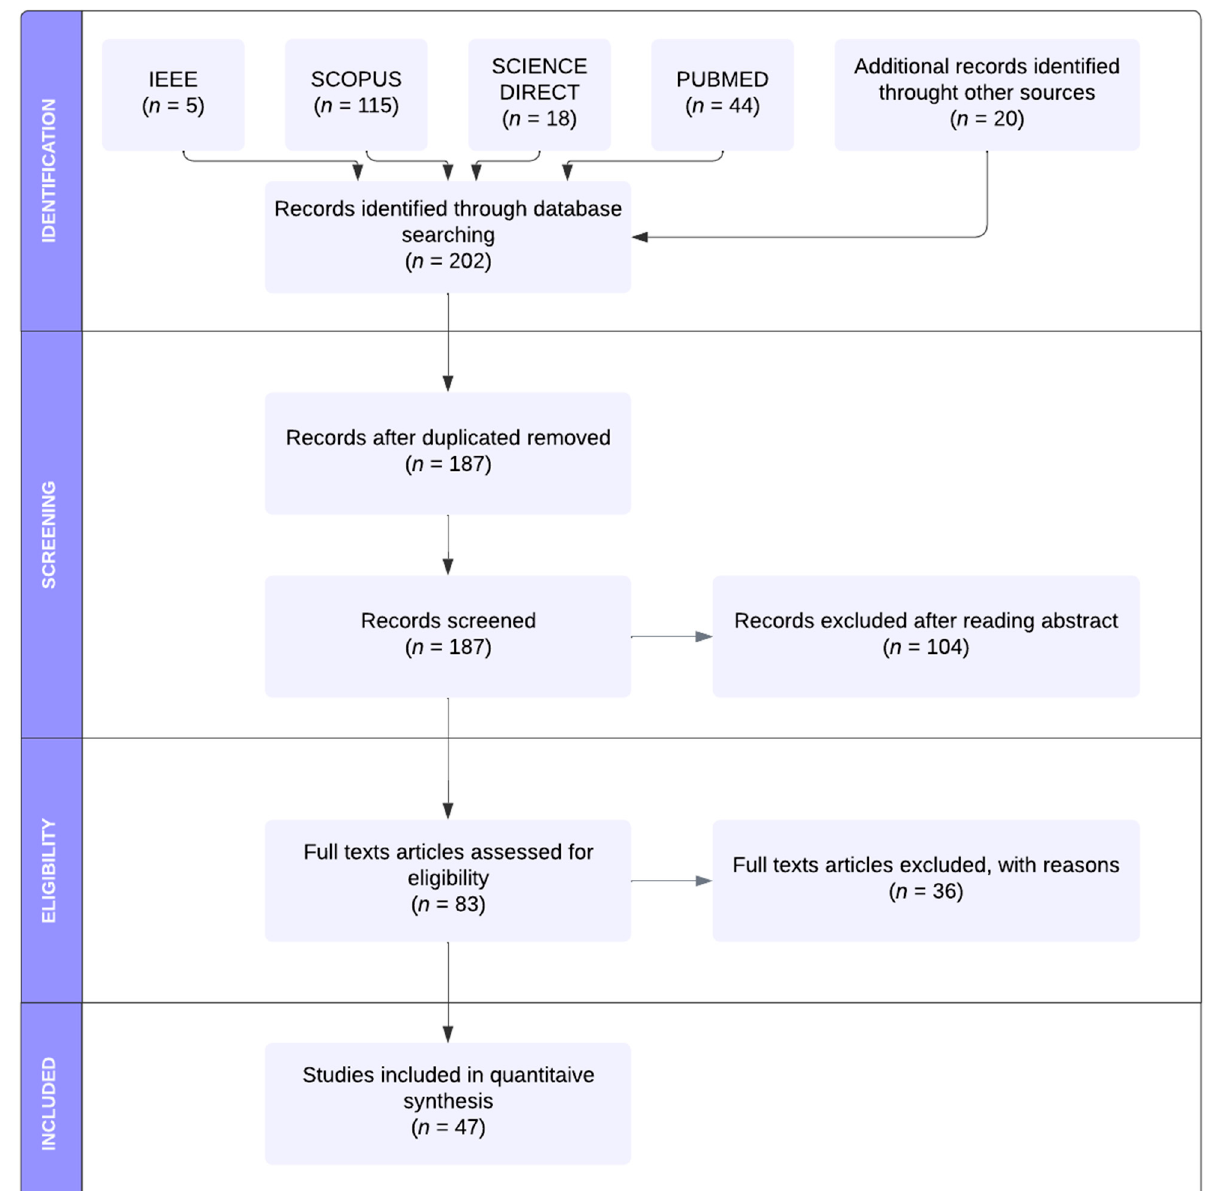
Figure 1. PRISMA workflow of the identification, screening, eligibility and inclusion of the studies in the systematic review. the systematic